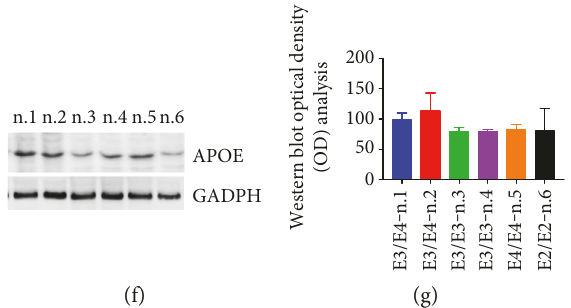
Figure 1: NSCs are completely di ff erentiated after 5 weeks in culture. (a) β III Tubulin, MAP-2, and A β immuno fl uorescence analysis in stem cells with or without APOE4 allele expression. Note that the anti-A β antibody also detects full length APP. Pictures are representative of fi ve di ff erent experiments performed in triplicate. Scale bar: 7 μ m. Arrows show the appearance of swollen varicosities along the neurites, likely indicative of a progressive neurodegeneration. (b) Optical density (OD) analysis of GAP43 and (c) GFAP band intensity in NSCs carrying the APOE4 genotype from two to fi ve weeks of culture. Data are normalized to the basal GADPH level and are expressed as % of the corresponding protein level at two weeks in culture. (d) ELISA quantitative analysis of A β 42 levels in the media of neurons after four and six weeks in culture. (e) The ratio of A β 42/A β 40 (Ab42/Ab40) from two to fi ve weeks in culture (2 – 5). Each data point is the mean ± SEM of triplicate determinations of fi ve independent experiments ( n = 5 ). ∗ P < 0 05 and ∗∗ P < 0 01 versus week three of each NSC. One-way ANOVA with post hoc Tukey ’ s test. (f) WB analysis of Apo-E4 protein in culture of NSCs (n.1 – 6) after fi ve weeks in culture. Densitometry analysis is reported in (g). Data are expressed as % of control